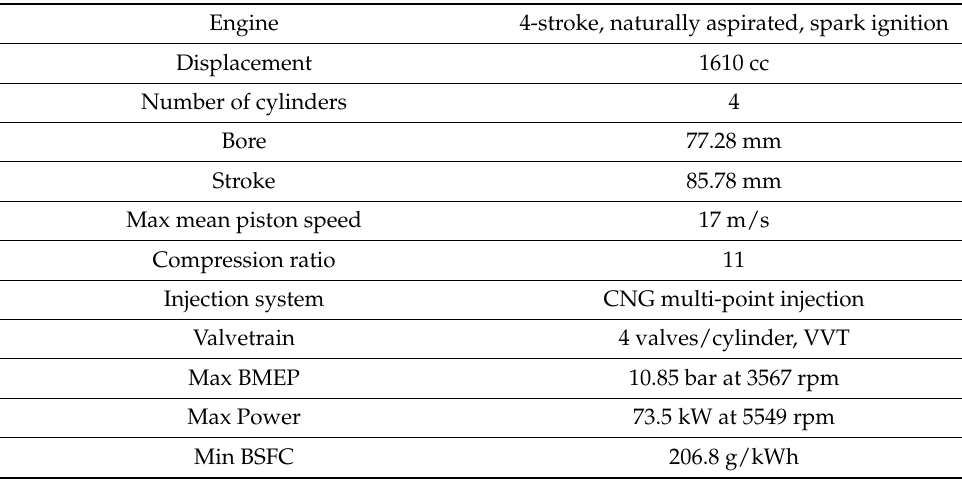
Figure 8. Brake specific fuel consumption map of the CNG -fueled naturally aspirated engine. Table 3. Main characteristics of the baseline CNG -fueled S.I. naturally aspirated